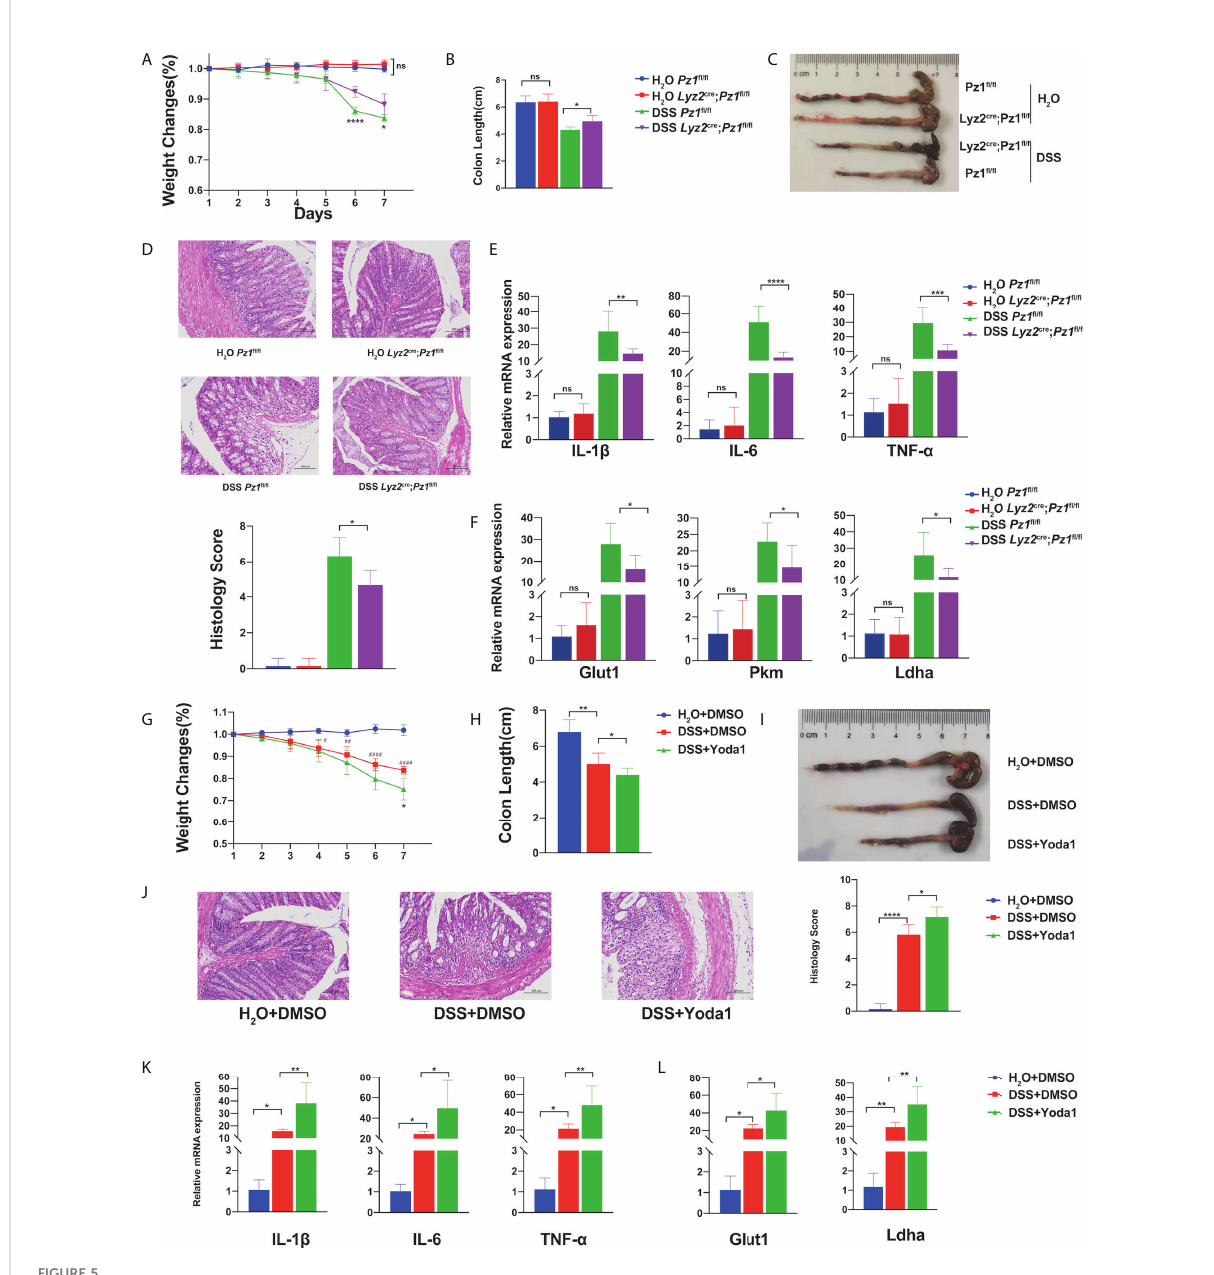
FIGURE 5 Piezo1 de fi ciency ameliorates murine ulcerative colitis . Lyz2 cre/+ Piezo1 fl ox/ fl ox and Piezo1 fl ox/ fl ox control mice were challenged with water or 3% DSS in drinking water for seven days (n = 7). (A) Body weight loss, (B, C) colon length, (D) representative hematoxylin and eosin (H&E)-stained colon cross-sections, and histological scores were measured. (E) mRNA expression of IL-1 b , IL6, and TNF- a in colon tissue. (F) mRNA expression of Glut1, Pkm, and Ldha in macrophages in the lamina propria. Mice were challenged with 3% DSS in drinking water for 7 d, to which 0.4 mg/kg Yoda1 or DMSO were added on day 1 and day 4 (n = 5). (G) Body weight loss, (H, I) colon length, (J) representative H&E-stained colon cross-sections, and histological scores were measured. (K) mRNA expression of IL-1 b , IL6, and TNF- a in the colon tissue. (L) mRNA expression of Glut1, Pkm, and Ldha in macrophages of the lamina propria. Statistical signi fi cances were calculated using (A) two way ANOVA, *P < 0.05; **** P < 0.0001 (DSS Piezo1 fl ox/ fl ox versus DSS Lyz2 cre/+ Piezo1 fl ox/ fl ox ); (G) two way ANOVA, *P < 0.05 (DSS+DMSO versus DSS +Yoda1); # P < 0.05, # # P < 0.01, #### P < 0.0001 (H 2 O+DMSO; DSS+DMSO); (B – F, H – L) one-way ANOVA, Tukey ’ s multiple comparisons test. Data are expressed as the mean ± SD. *P < 0.05, **P < 0.01, ***P < 0.001; **** P < 0.0001, ns, not signi fi cant. Lyz2 cre/+ Piezo1 fl ox/ fl ox , conditionally Piezo1-de fi cient mice; DSS, dextran sulfate sodium; IL, interleukin; TNF- a , tumor necrosis factor a